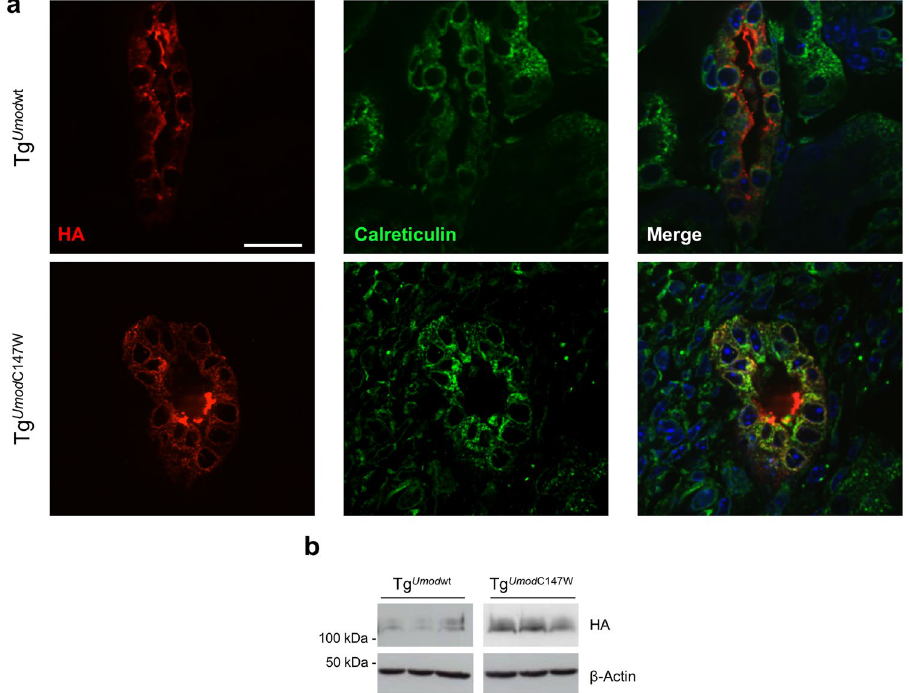
Figure 6. ER retention of mutant uromodulin in young Tg Umod C147W mice. ( a ) Immunofluorescence analysis for transgenic uromodulin (HA) and the ER marker calreticulin in Tg Umod wt (upper panel) and Tg Umod C147W (lower panel) mice at p8. Wild-type transgenic uromodulin is enriched at the apical plasma membrane of TAL cells, while most of the transgenic mutant protein is retained in the ER (scale bar 15 µ m). ( b ) ER retention of mutant uromodulin is also evident in Western blot experiment, in which samples from Tg Umod C147W kidneys show a more intense signal for the lower molecular weight uromodulin isoform, corresponding to the protein ER precursor. The figure shows cropped blots (full blots are reported in Supplementary Figure 6).